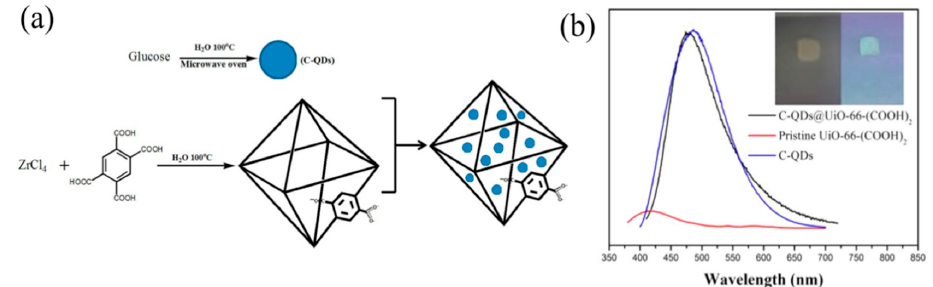
Figure 14. ( a ) Fabrication of C-QDs@UiO-66-(COOH) 2 (C-QDs = carbon quantum dots) composite; ( b ) Photoluminescence (PL) emission spectra of C-QDs, C-QDs@UiO-66-(COOH) 2 , and UiO-66-(COOH) 2 dispersed in a water solution excited at 365 nm. Reprinted with permission from Reference [74]. Copyright 2018 the American Chemical Society, (Washington, DC, USA).